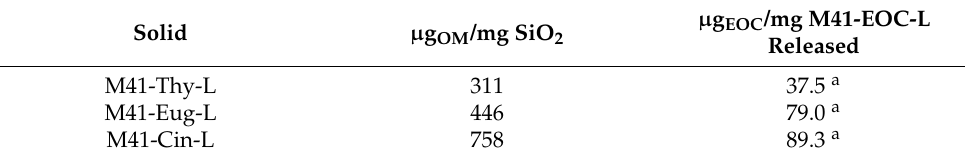
Table 2. Organic matter content ( µ g OM /mg SiO 2 ) and EOC payload released ( µ g/mg of M41-EOC-L) for each M41-EOC-L